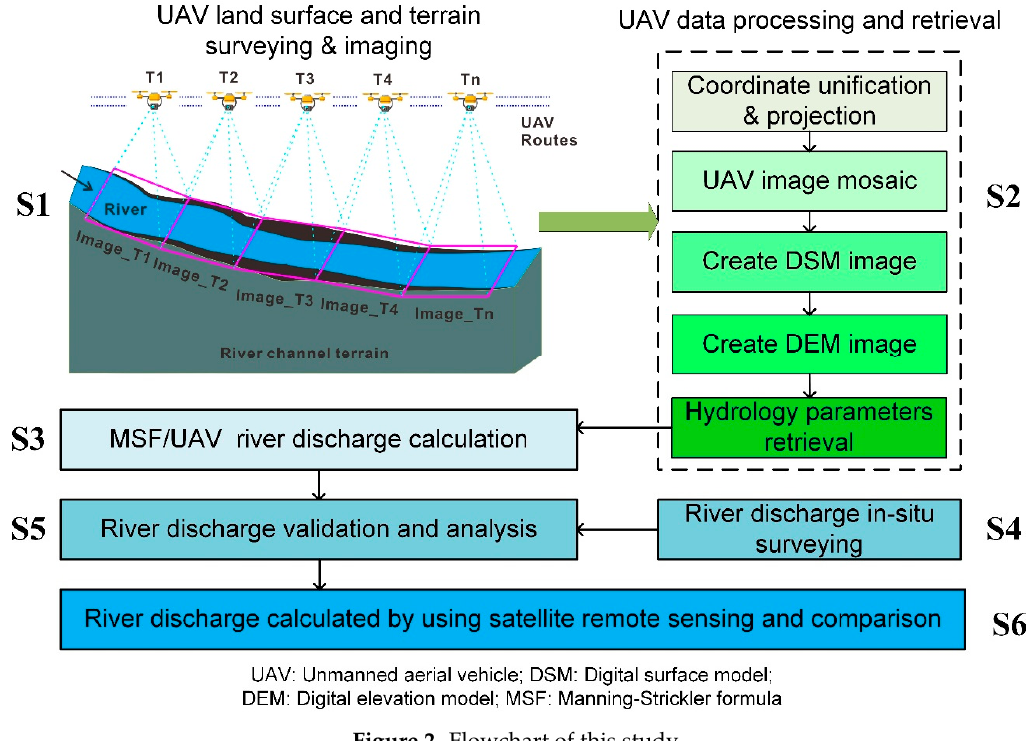
Figure 2. Flowchart of this study.